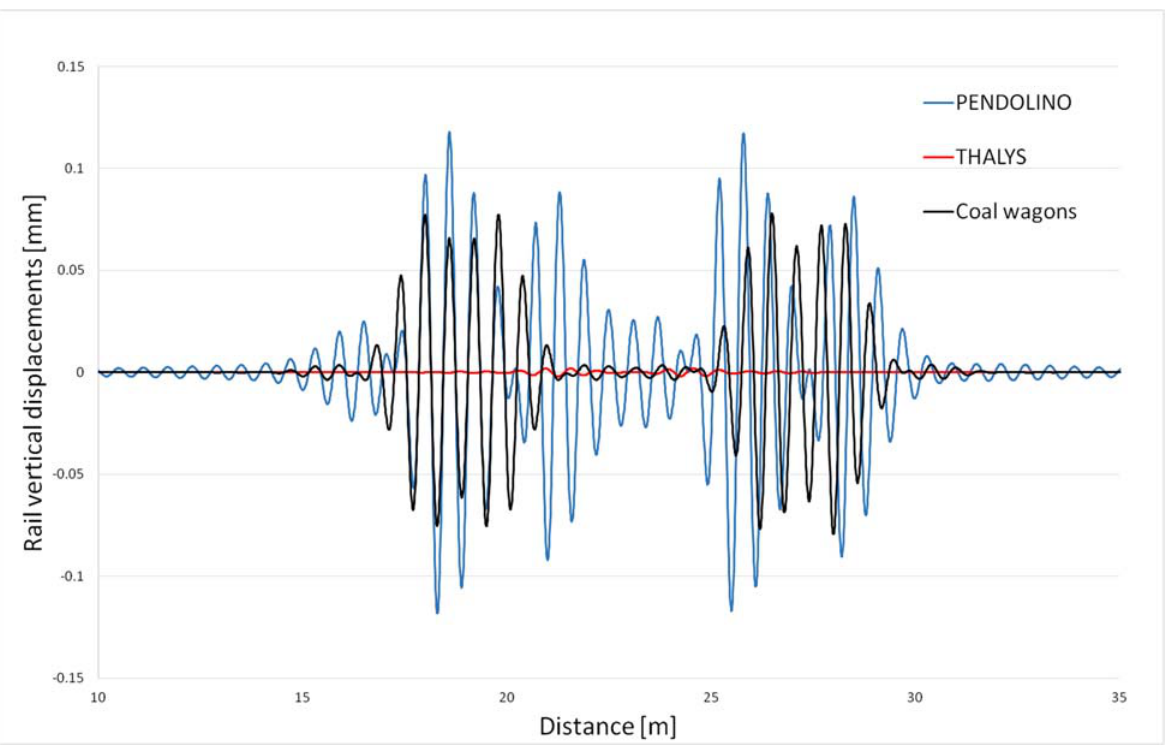
Figure 6: Maximum di ff erence of a two - layer ( 2 - L ) and a one - layer ( 1 - L ) model displacements ( v = 100 km/h, k r = 91.1 MPa, imperfection s = 10 μ m, and L = 0.6 m ) . n